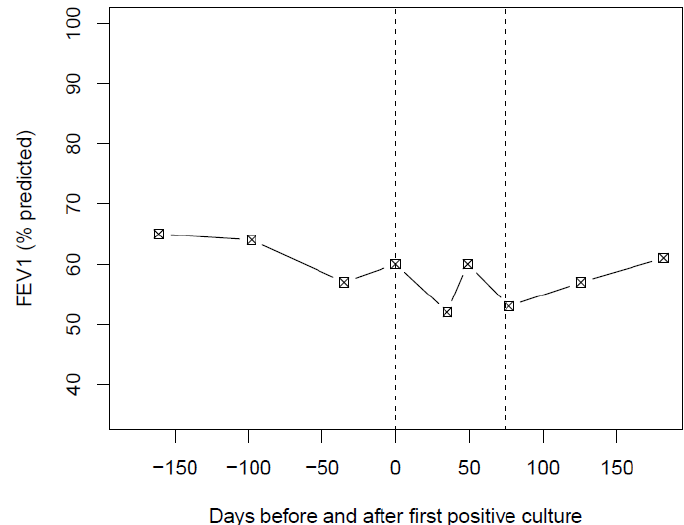
Figure 1. Lung function before and after positive sputum culture for Elizabethkingia miricola. ������� ������ ���������� ��� ���� �������������� ������ ���������� ��� ���� ������� b��w��� w��c� f�u� ���u�u� cu��u���� w��� �������v� f�� E.